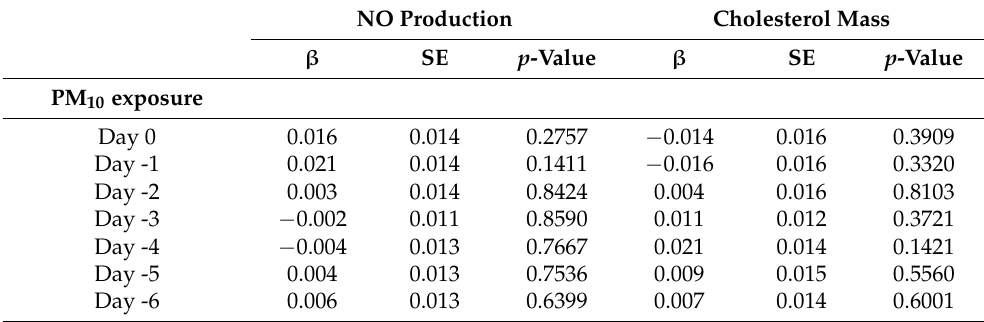
Figure 1. Frequency distribution of HDL function and impact of BMI. ( A ), Frequency distribution of NO production by endothelial cells exposed to apoB-D sera in the whole cohort and by BMI groups. Data are expressed as fold increase in untreated cells. ( B ), Frequency distribution of cholesterol mass of macrophages exposed to apoB-D sera in the whole cohort and by BMI groups. Results are expressed as fold reduction in untreated cells. All data are presented as histograms and boxplots; squares indicate the mean values and dots the outliers. Table 3. Association between HDL-mediated NO production, HDL-mediated reduction in cholesterol mass, and PM